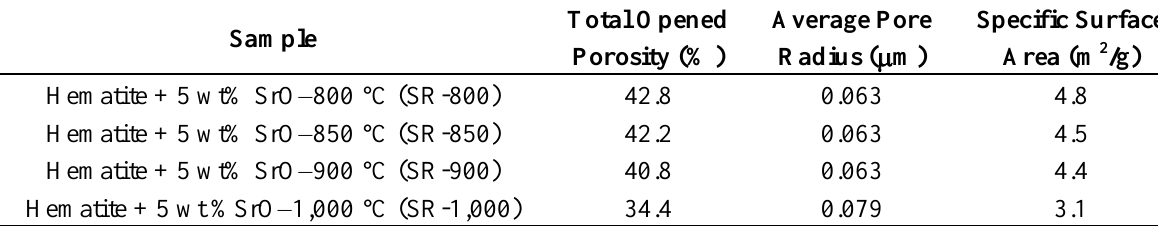
Table 3. Total opened porosity, average pore radius and specific surface area determined by MIP (average of two